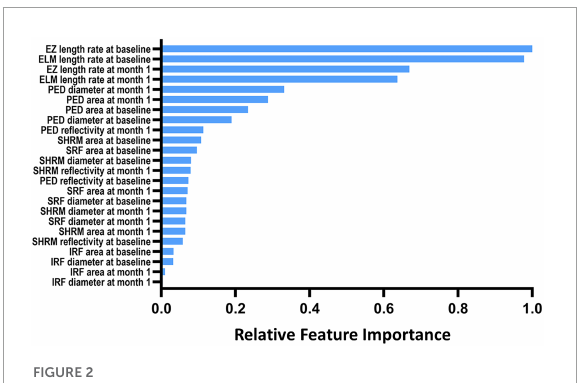
FIGURE2 The relative importance of optical coherence tomography imaging biomarkers for the prediction of 1-year disease activity. IRF, intraretinal fluid; SRF, subretinal fluid; PED, pigment epithelial detachment; SHRM, subretinal hyperreflective material; EZ, ellipsoid zone; ELM, external limiting membranes.